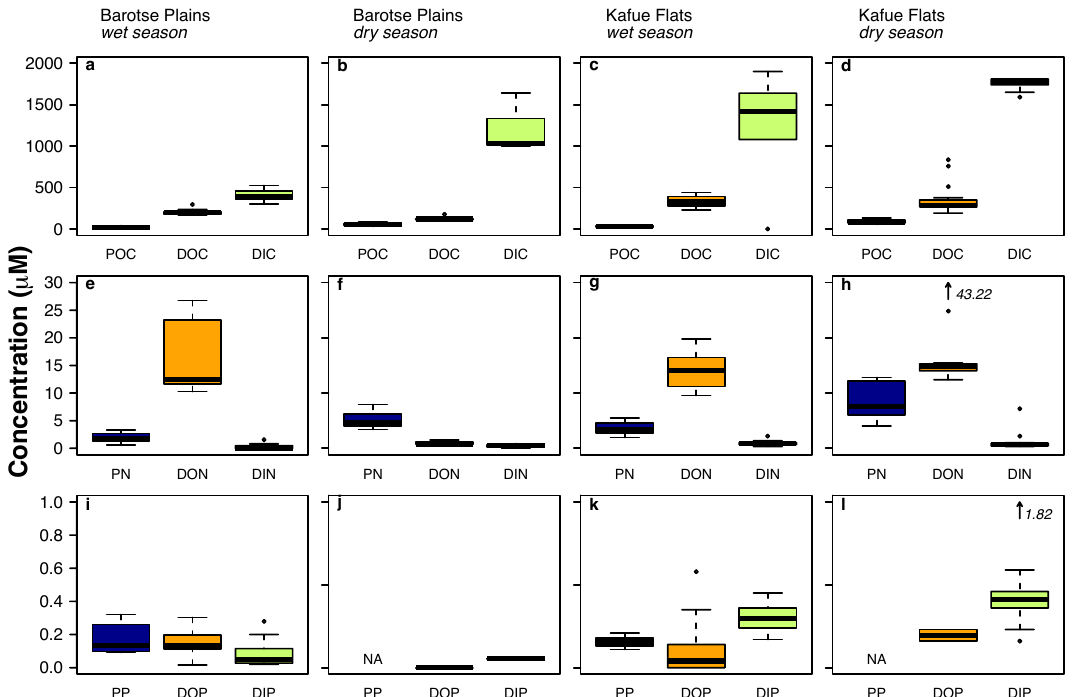
Figure 4. Boxplots of the concentrations of dissolved and particulate carbon, nitrogen, and phosphorus species along the Barotse Plains and the Kafue Flats during wet and dry seasons along the floodplain. The boxes represent the first and third quartiles, and the median. No measurements of particulate phosphorus were made on samples from the dry seasons. Carbon and nitrogen data of the Kafue Flats have been previously published in Zurbrügg et al. (2013).